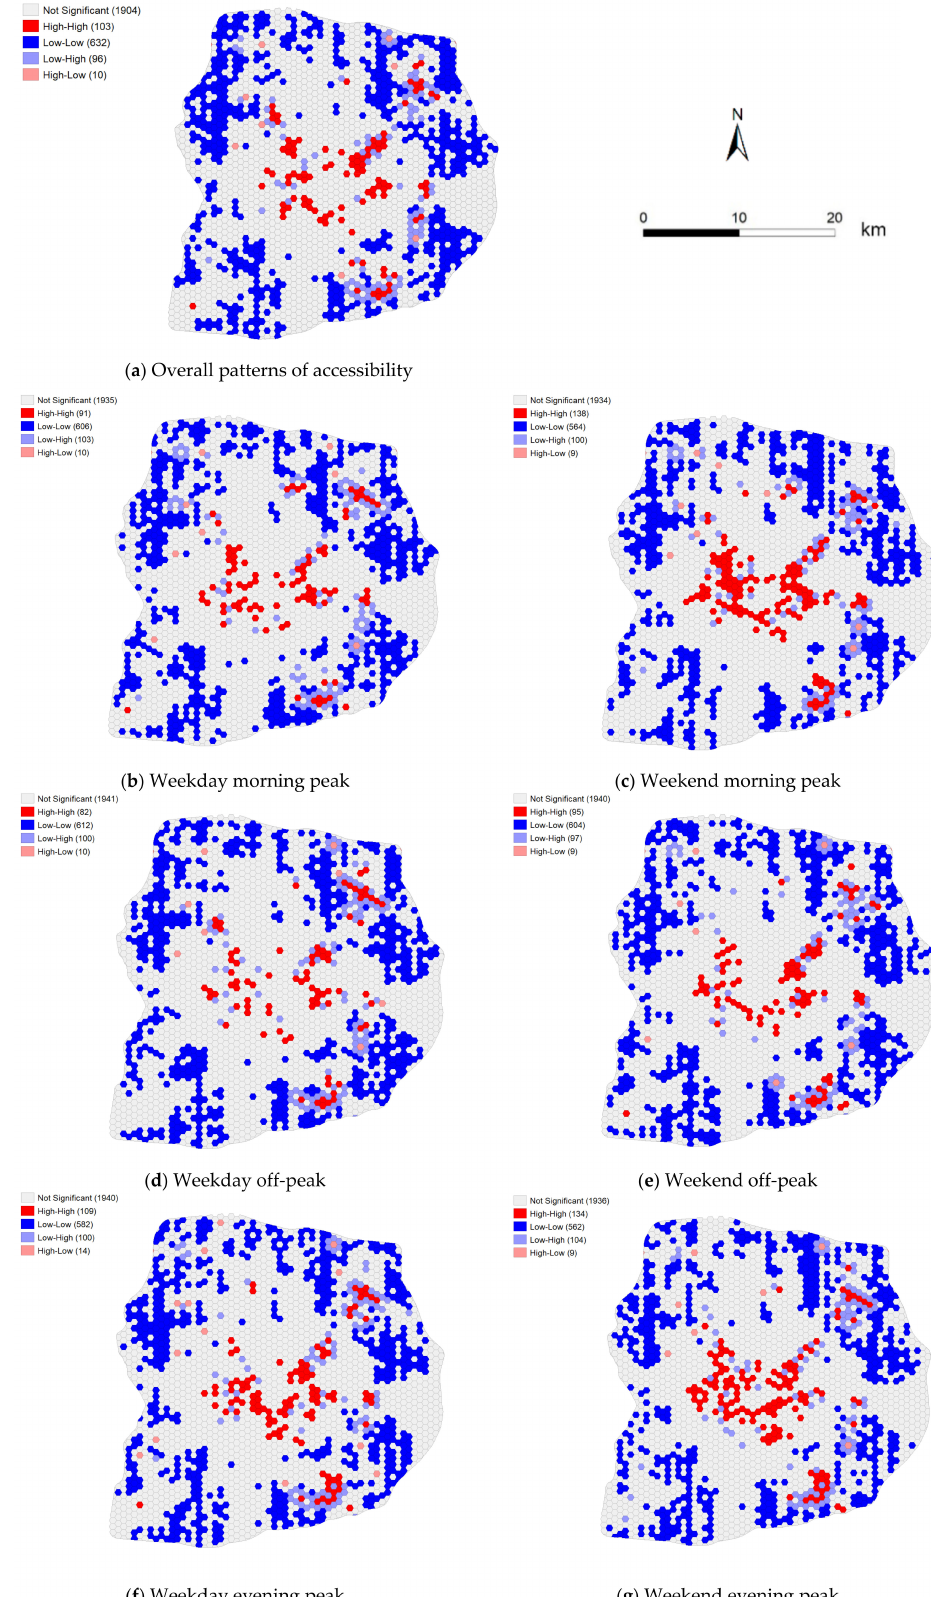
Figure 10. Local indicators for spatial association cluster maps of hospital accessibility. ( a ) Moran’s I of the overall patterns in accessibility; ( b , d , f ) Moran’s I of weekday accessibility in different time periods; and ( c , e , g ) Moran’s I of weekend accessibility in different